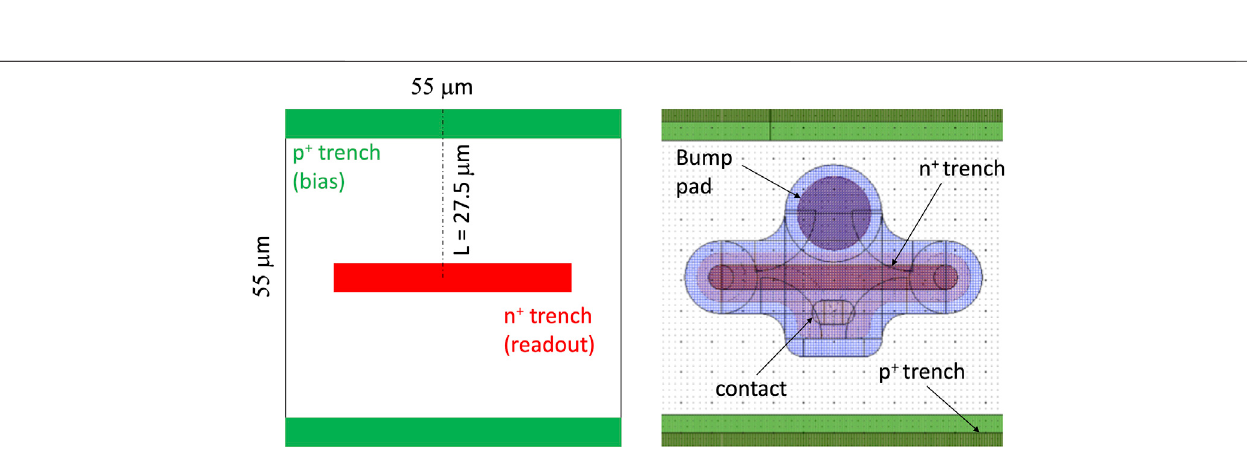
FIGURE 4 | Conceptual design (left) , and layout (right) of a 3D pixel with trenched electrodes.